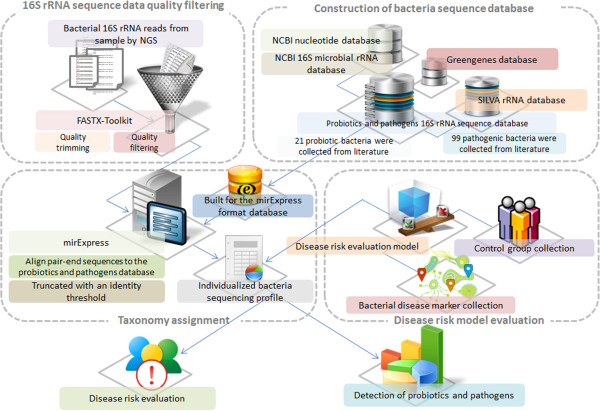
System flow of bioinformatics analysis in the proposed platform. The proposed platform comprises the analysis pipeline of NGS, construction of probiotics and pathogens database, bacterial disease risk model evaluation and the application of individualized bacteria sequencing profile.